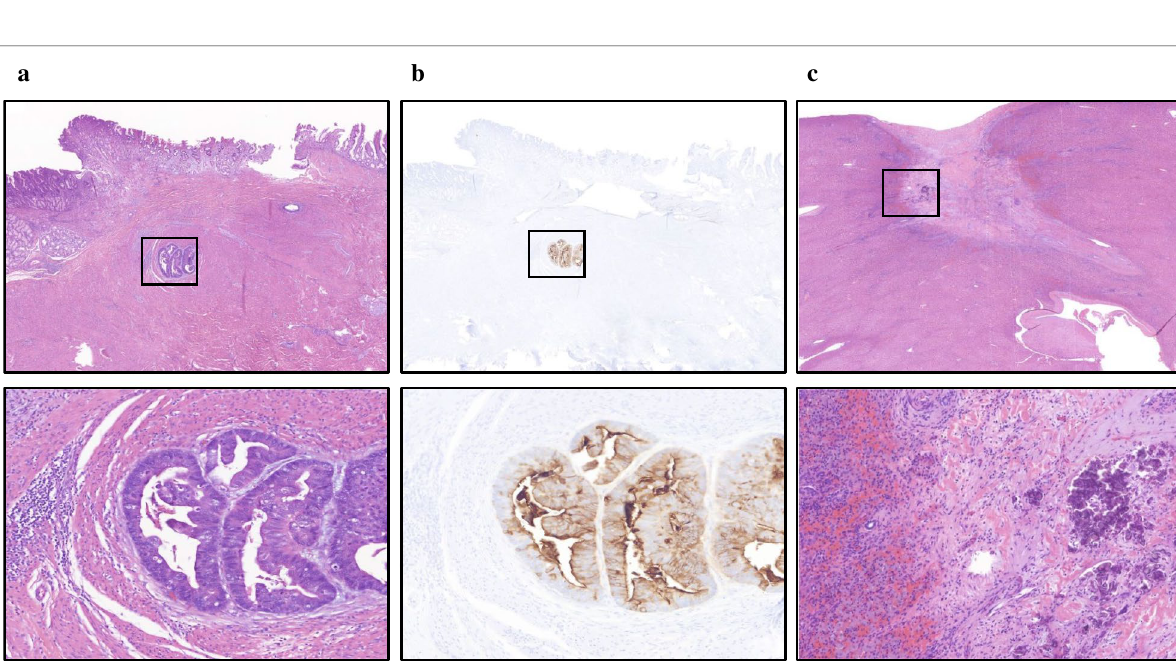
Fig. 5 Microscopic findings of resected organs. a Stomach; Viable tumor cells were observed in less than one-third of the lesion and more than two-thirds were replaced with scar tissue. b AFP immunochemistry; AFP was focally stained in the primary lesion. c Liver; Only scar tissue without viable cancer cells was